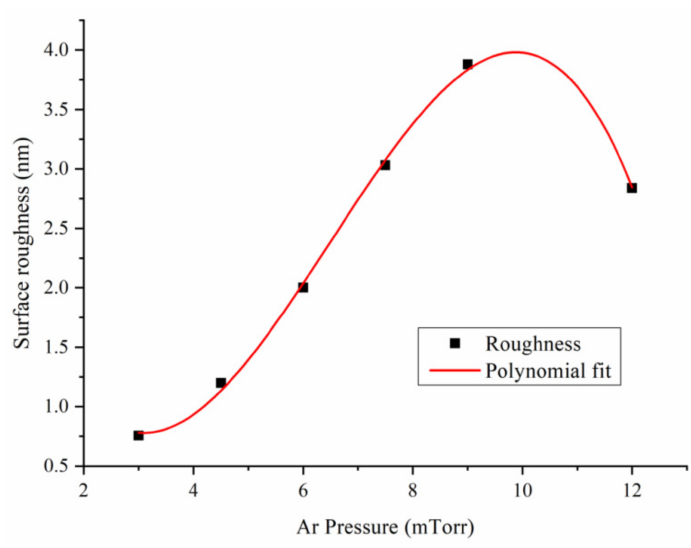
Figure 5. The lattice constant versus Ar pressure.